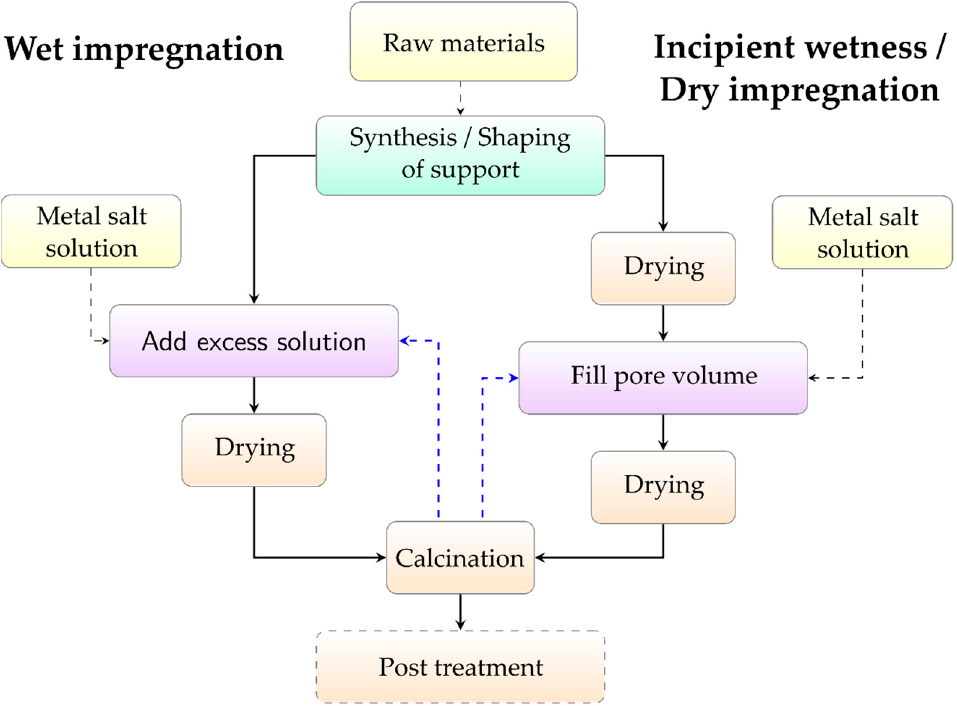
Figure 19. A simple flowchart of the impregnation processes.